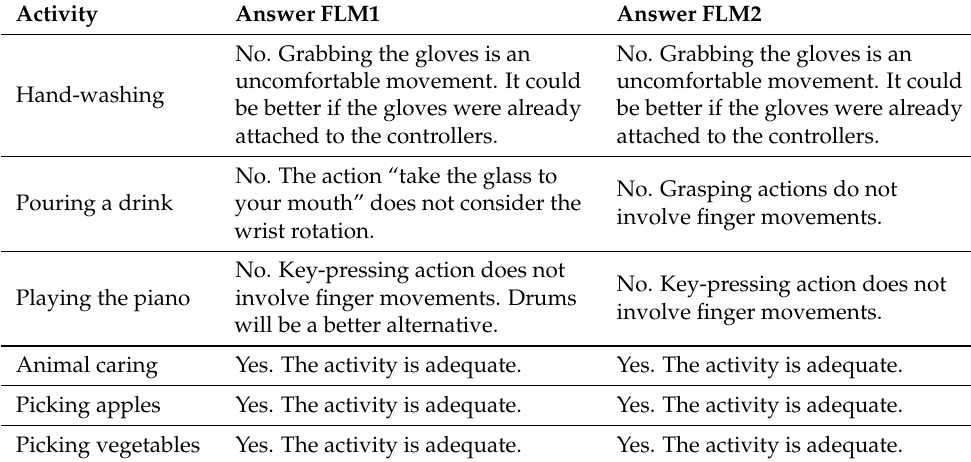
Table 7. Results of activities’ evaluation by FLM experts.